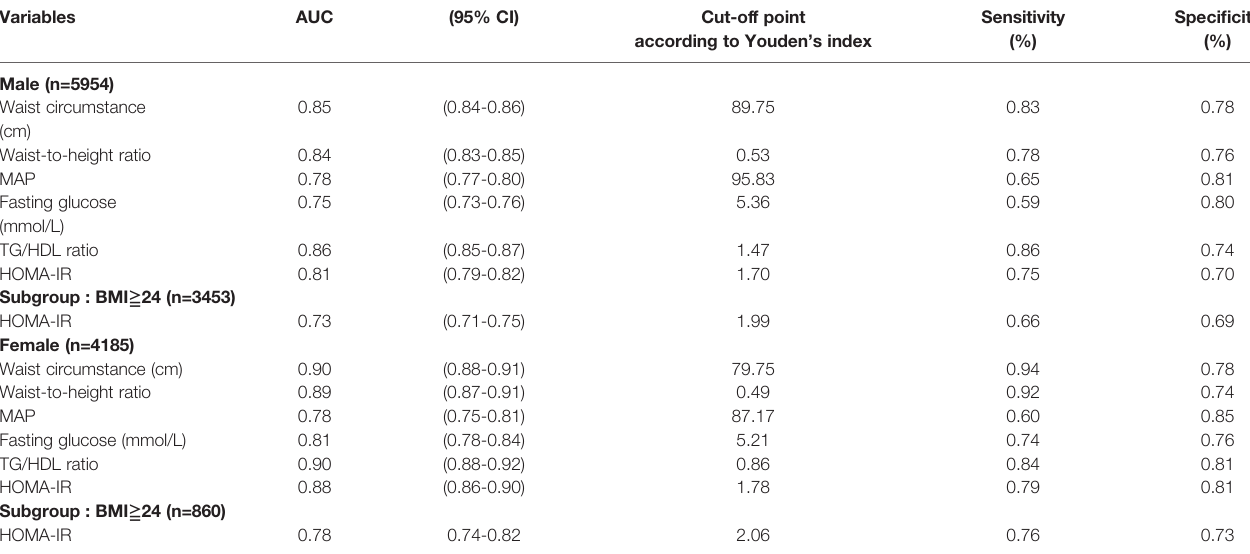
TABLE 2 | The areas under ROC curve (AUC), sensitivity and speci fi city by the optimized cut-off points for cardiometabolic risk factors in prediction of metabolic syndrome according to gender and obesity status. Variables